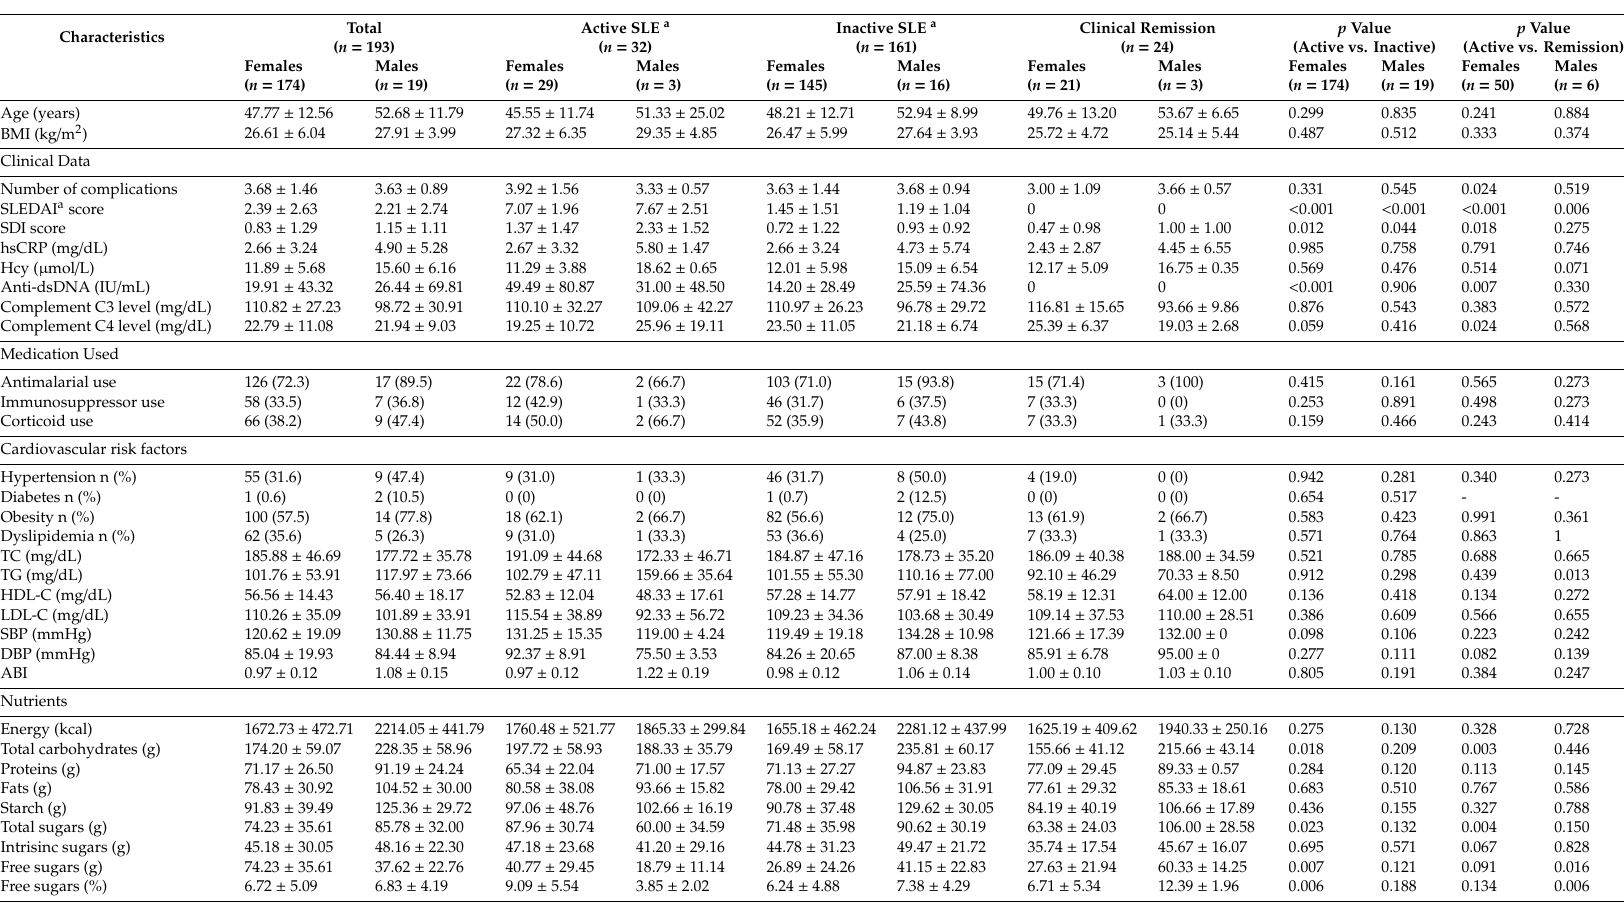
Table 2. Descriptive of the main characteristics the study population classified as, active / inactive SLE and clinical remission according to gender.